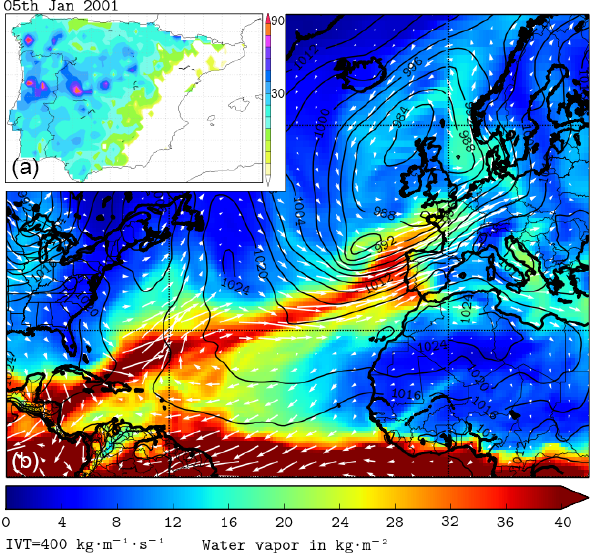
Figure 1. An AR as it makes landfall in Galicia (NW Spain) on 5 January 2001. The field represents the IWV (kgm − 2 ), while the arrows symbolize the integrated water vapor flux or IVT (kgm − 1 s − 1 ). Panel (a) displays extreme precipitation (more than 90mm in 24h) accumulated throughout the Iberian Peninsula.